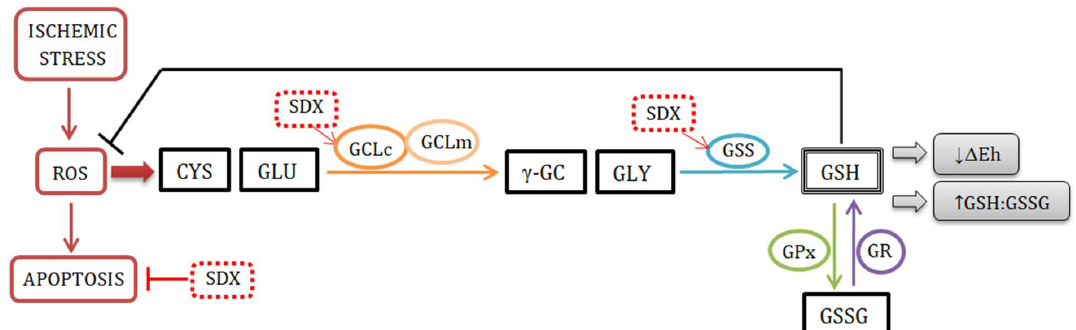
Figure 4. The mechanism of SDX antioxidant action. Abbreviations: ROS, reactive oxygen species; CYS, cysteine; GLU, glutamate; GCLc, catalytic subunit of glutamate–cysteine ligase; GCLm, modifier subunit of glutamate–cysteine ligase; γ-GC, γ-glutamyl cysteine; GLY, glycine; GSS, glutathione synthase; GSH, reduced form of glutathione; GPx, glutathione peroxidase; GSSG, oxidized form of glutathione; GR, glutathione reductase; ∆Eh, redox potential; SDX, sulodexide; → , induction; ┴ , inhibition.